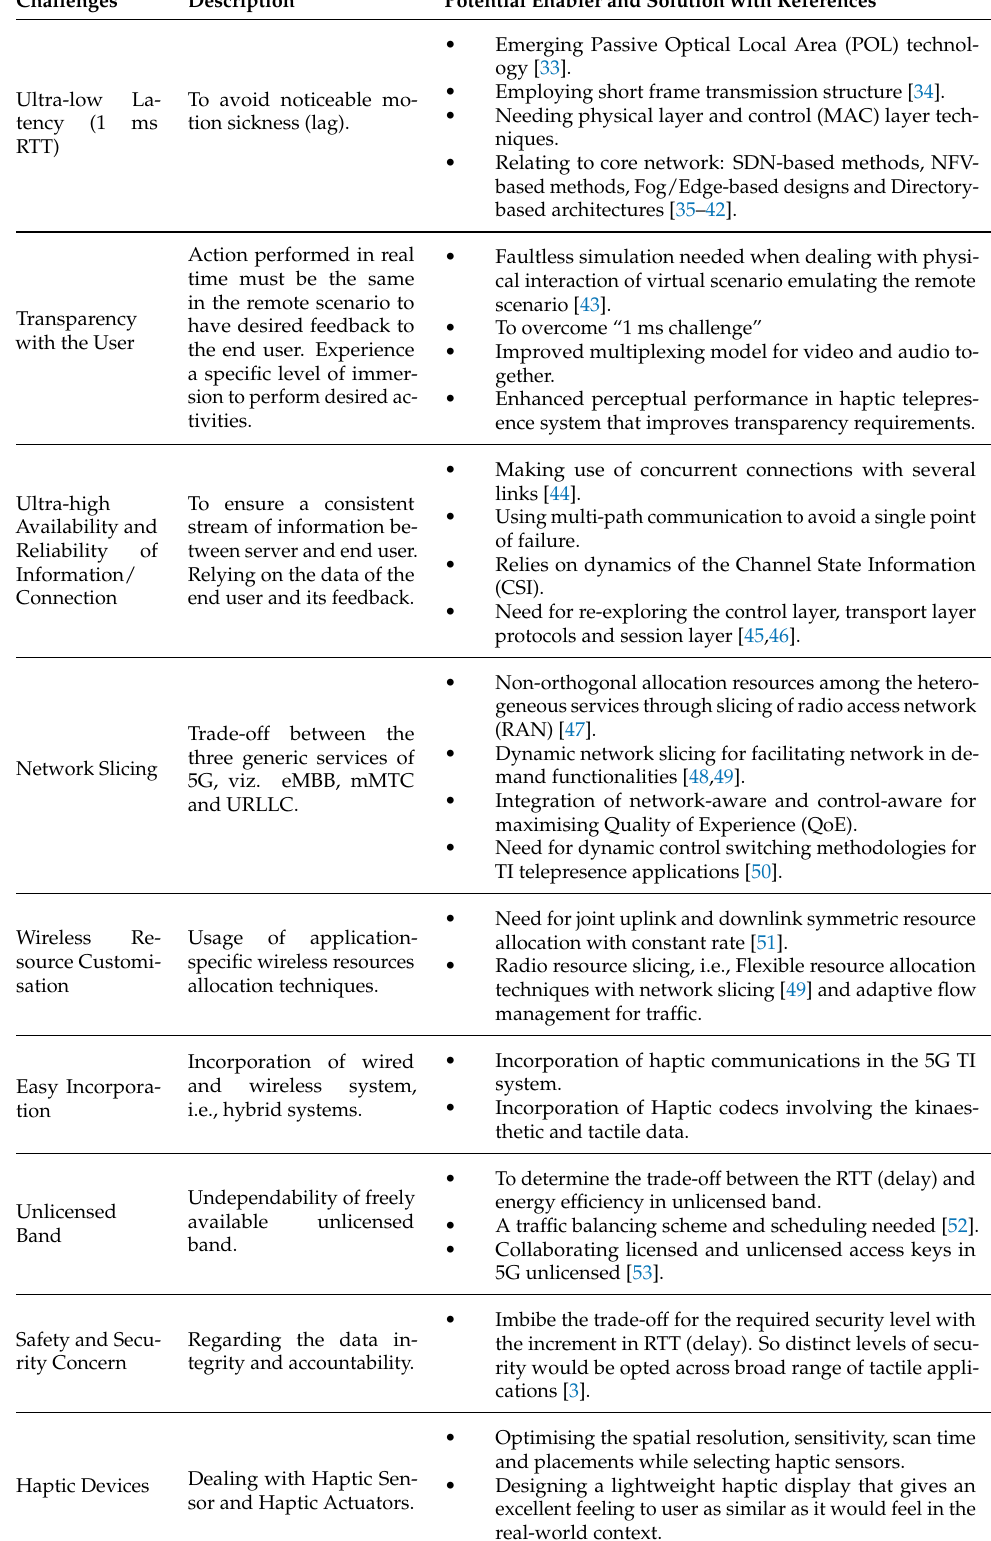
Table 3. Open challenges with descriptions and potential